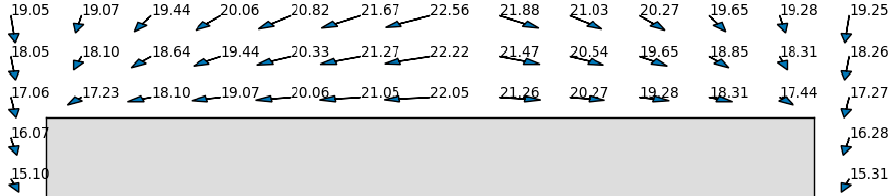
Figure 11. Ridge boundary in the middle of this figure to separate cells into left and right parts with different moving directions.